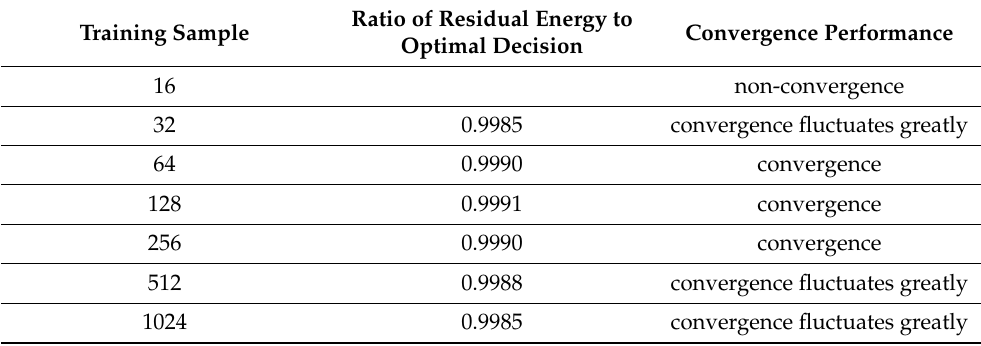
Table 3. The effect of training sample size on algorithm performance. Here, we set the experience replay pool size to 1024 and N = 8.